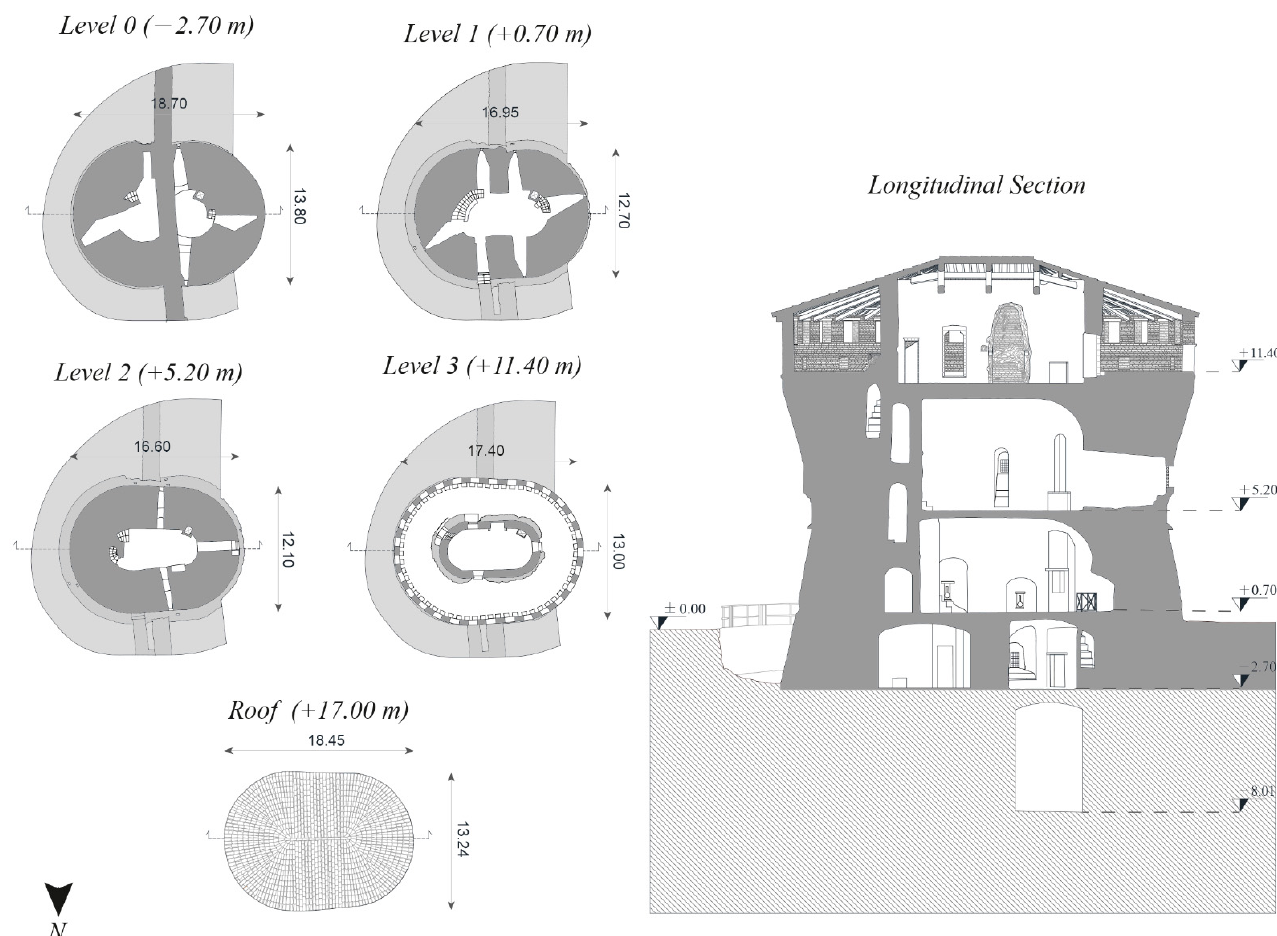
Figure 2. Horizontal and longitudinal cross-sections of the fortified tower (dimensions are in meters).